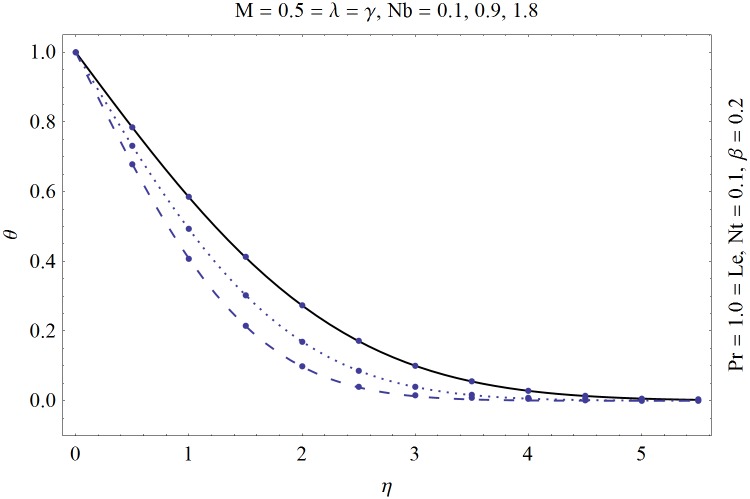
Comparison of analytic (solid line) and numeric (dots) solutions for temperature.